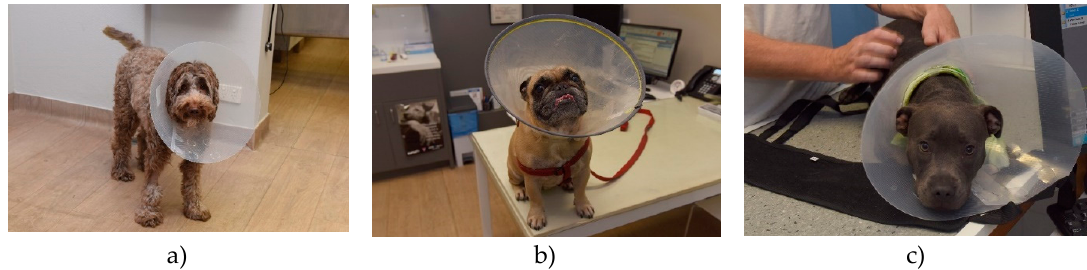
Figure 2. (a)–(c) : Dogs wearing commercially available, adjustable rigid plastic Elizabethan collars to protect surgical wounds.